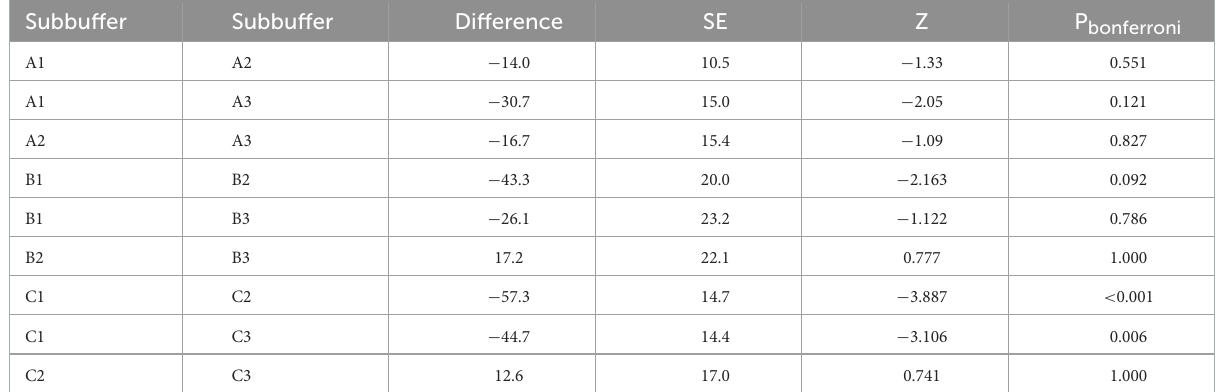
TABLE 1 Post-hoc comparison tests for the generalized linear models regarding differences between